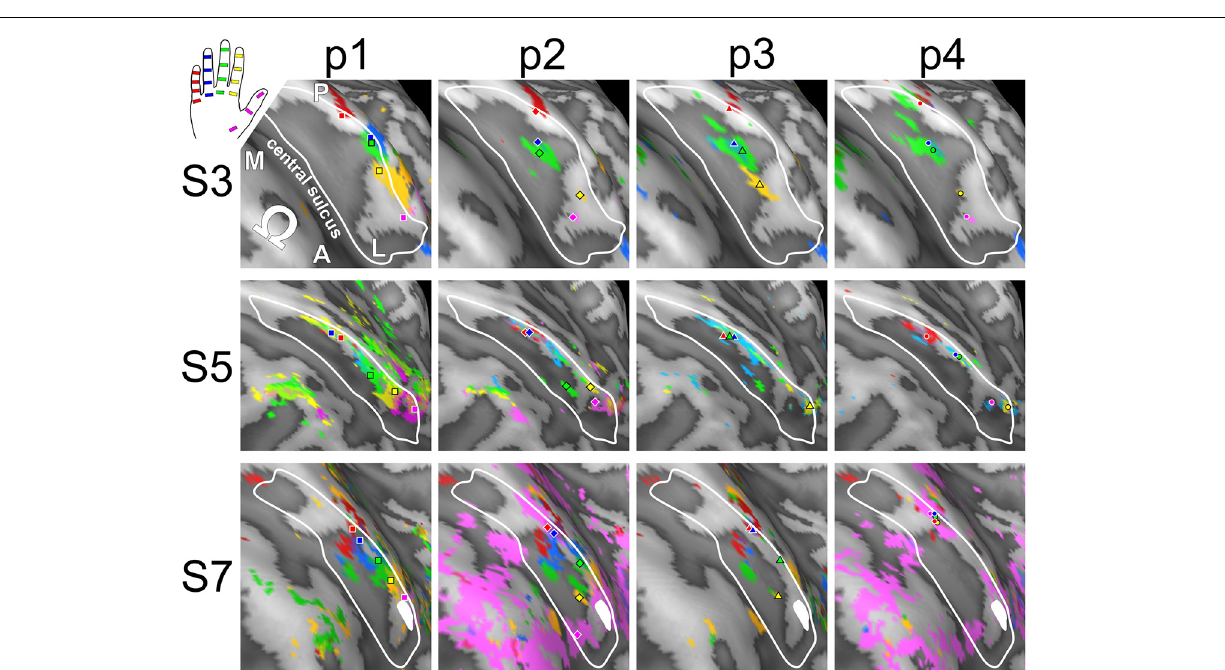
A-P, anterior-posterior; M-L, medial-lateral). The area used for peak–vertex analysis is marked (white border). Each column shows the activations for homologous phalanges p1, p2, and p3 as well as digit bases p4. Peak voxels are illustrated in the respective color. D1, magenta; D2, yellow; D3, green; D4, blue, and D5,